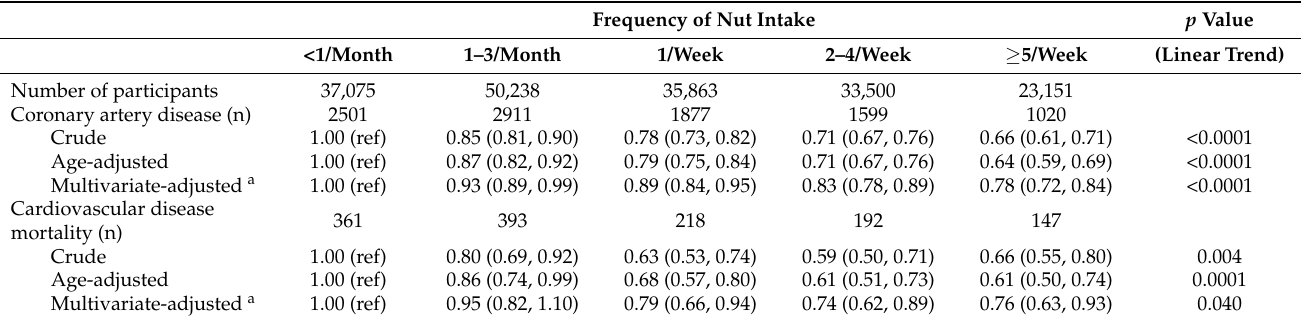
Table 4. Association of nut intake and incidence of cardiovascular disease mortality and coronary artery